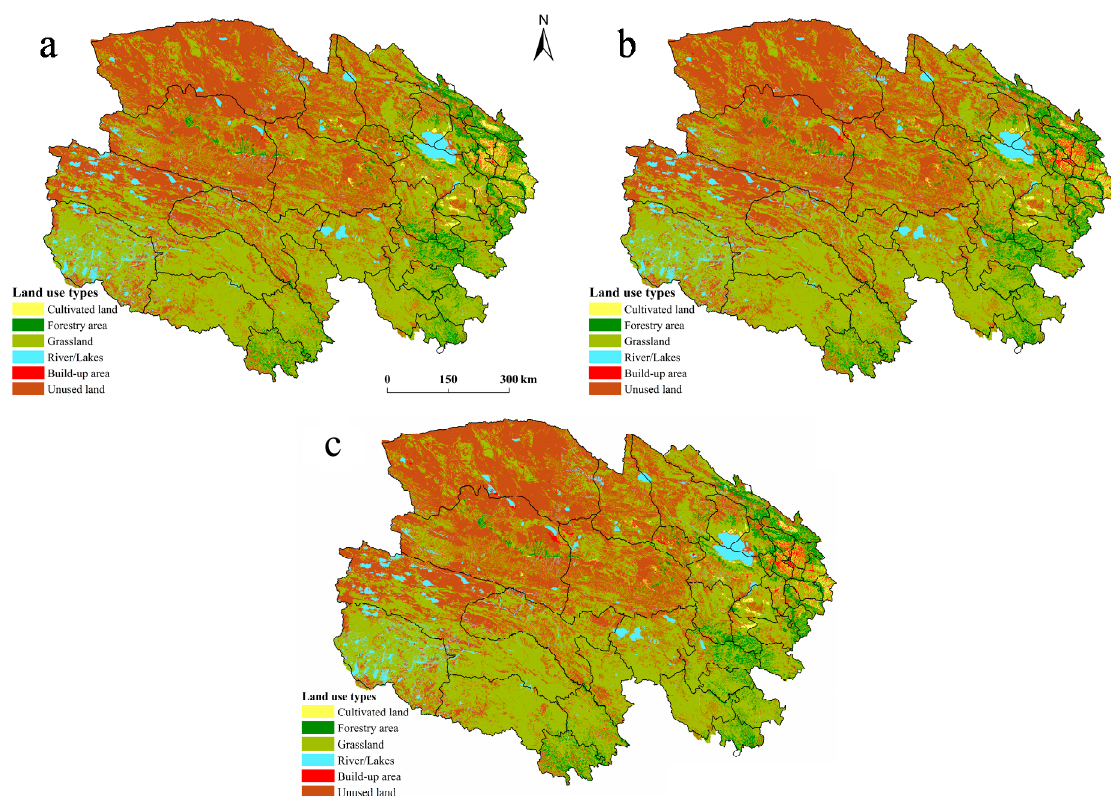
Figure 2. Land use situation in Qinghai Province in: ( a ) 1988, ( b ) 2000 and ( c ) 2008. Table 3. Land use dynamic degree in Qinghai Province in different periods (unit: %). Land Use